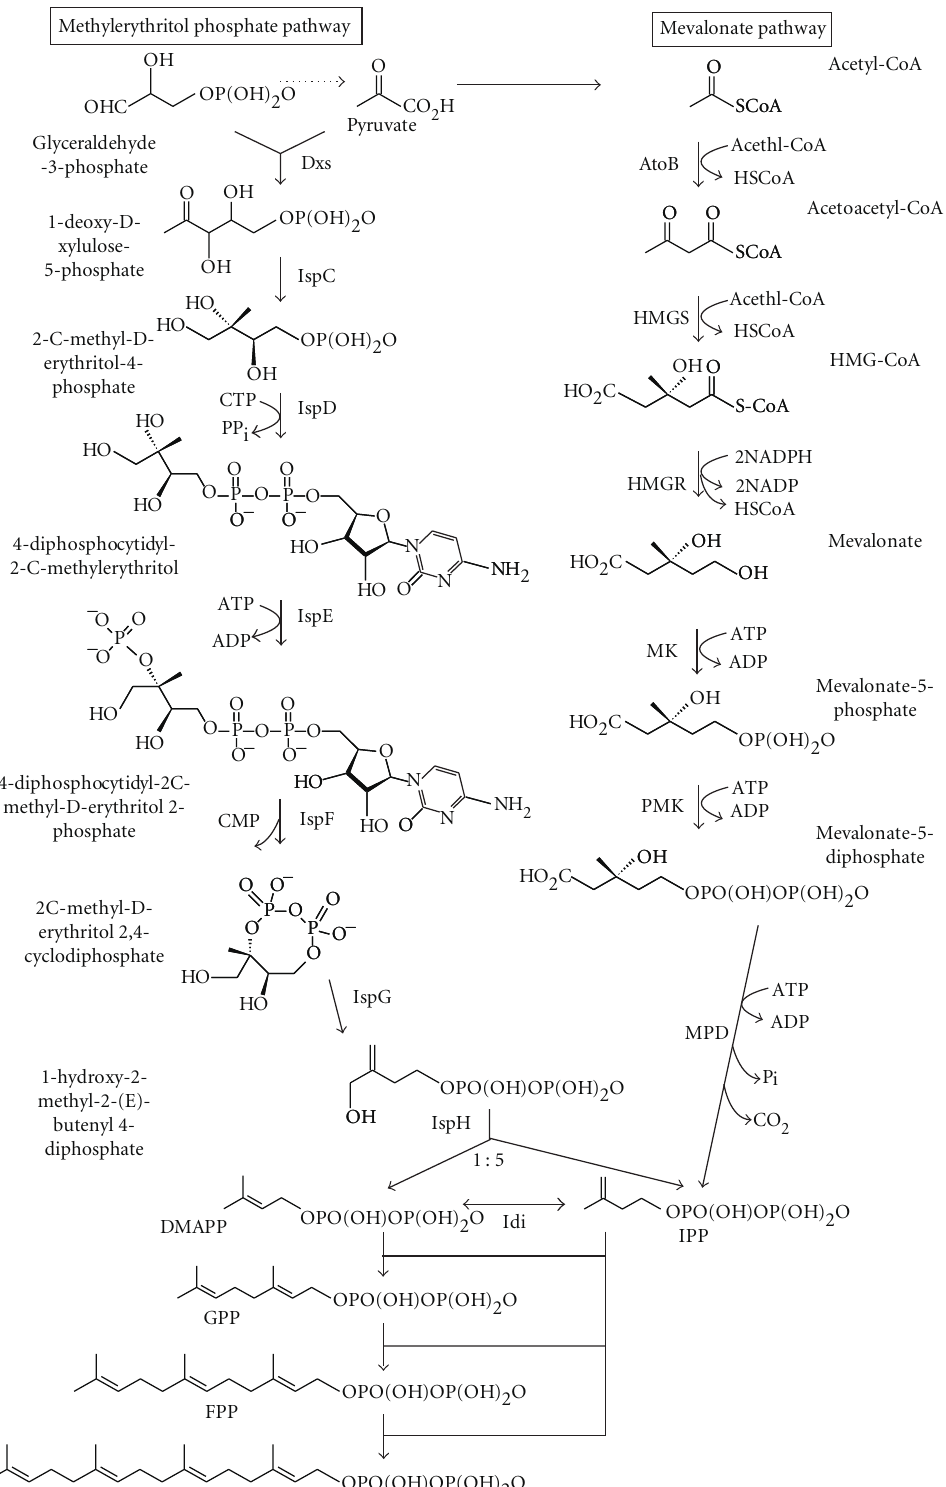
Figure 1: Biosynthetic routes to polyprenyl pyrophosphate terpenoid biosynthetic pathways . Dxs: 1-deoxy-d-xylulose-5-phosphate synthase; IspC: 1-deoxy-d-xylulose-5-phosphate reductoisomerase; IspD: 4-diphosphocytidyl-2-C-methyl-d-erythritol synthase; IspE: 4-diphosphocytidyl-2-C-methyl-d-erythritol kinase; IspF: 2-C-methyl-d-erythritol2,4-cyclodiphosphate synthase; IspG: 1-hydroxy-2- methyl-2-(E)-butenyl 4-diphosphate synthase; IspH: 1-hydroxy-2-methyl-2-(E)-butenyl 4-diphosphate reductase; AtoB, acetyl-CoA C- acetyltransferase; HMGS: hydroxymethylglutaryl-CoA synthase; HMGR: hydroxymethylglutaryl-CoA reductase; MK: mevalonate kinase; PMK: phosphomevalonate kinase; MPD: mevalonate pyrophosphate decarboxylase; Idi: isopentenyl pyrophosphate isomerase; GPP: geranyl pyrophosphate; FPP: farnesyl pyrophosphate; GGPP: geranylgeranyl